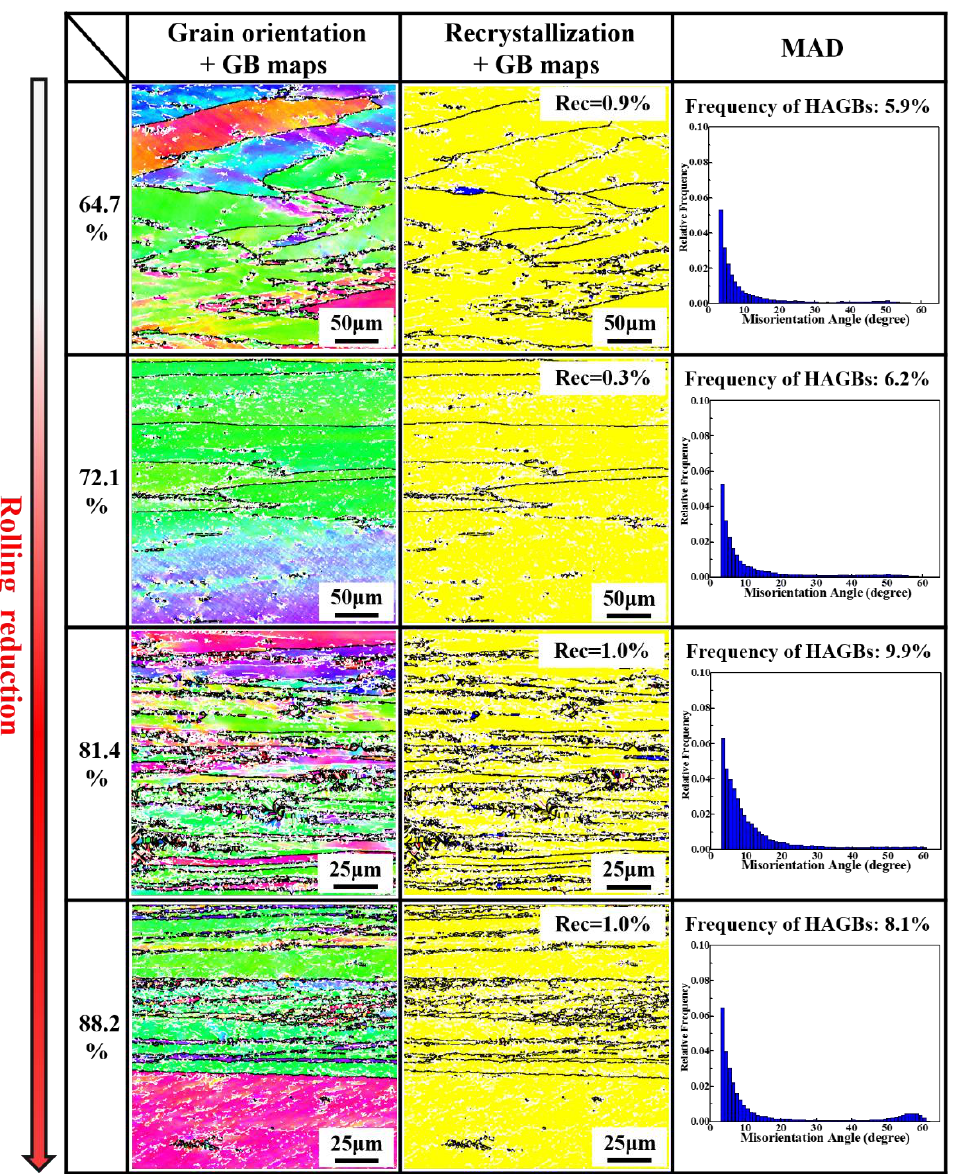
Figure 3. EBSD images of grain structure for the samples with different rolling reductions.